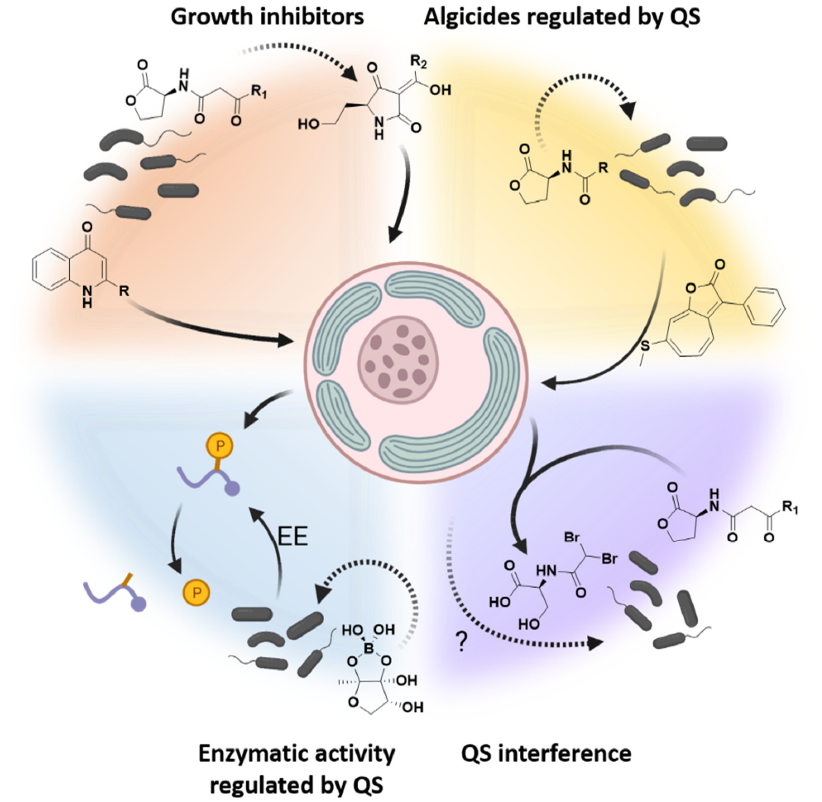
Figure 2. Graphical summary of the algae–bacteria interactions dictated by quorum-sensing signals in marine planktonic systems. These QS signals can be directly algicidal, as shown in the orange sector, such as alkyl-quinolones [57] and tetramic acids [43], which inhibit growth via photosynthesis inhibition. Quinolones and tetramic acids also arrest cell-cycle activities and several other metabolic processes in microalgae [42,58]. AHL-mediated quorum sensing regulates the production of other algicidal compounds (yellow sector), such as the roseobacticide shown [64]. Quorum sensing regulates extracellular enzymatic activity in marine bacteria (blue sector), allowing these microbes to capitalize on encounters with nutrient hotspots, such as by liberating phosphates from organic molecules (blue curves with orange P) on marine particles and in phycospheres [80,84]. Research is also hinting at the ways by which microalgae interfere with quorum sensing, shown in the lilac sector [104,107]. Dotted lines represent indirect actions of QS signals, while full lines represent direct effects. EE: extracellular enzymes. Created with